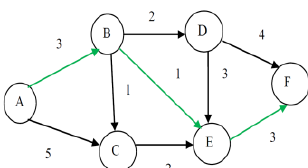
Figure 4. Example for the shortest path (Singal and Chhillar, 2014).